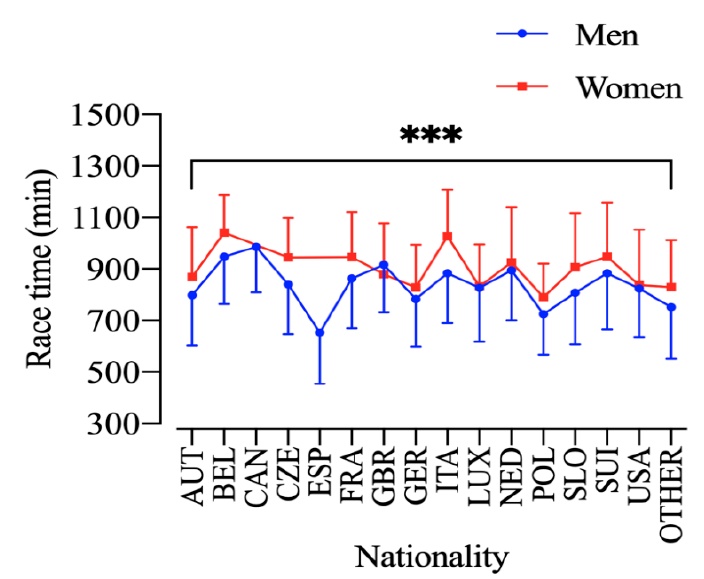
Figure 6. Performance of men and women in different countries. ***: sex, nationality and interaction effect ( p < 0.05). AUT = Austria, BEL = Belgium, CAN = Canada, CZE = Czech Republic, ESP = Spain, FRA = France, GBR = Great Britain, GER = Germany, ITA = Italy, LUX = Luxembourg, NED = Netherlands, POL = Poland, SLO = Slovenia, SUI = Switzerland.